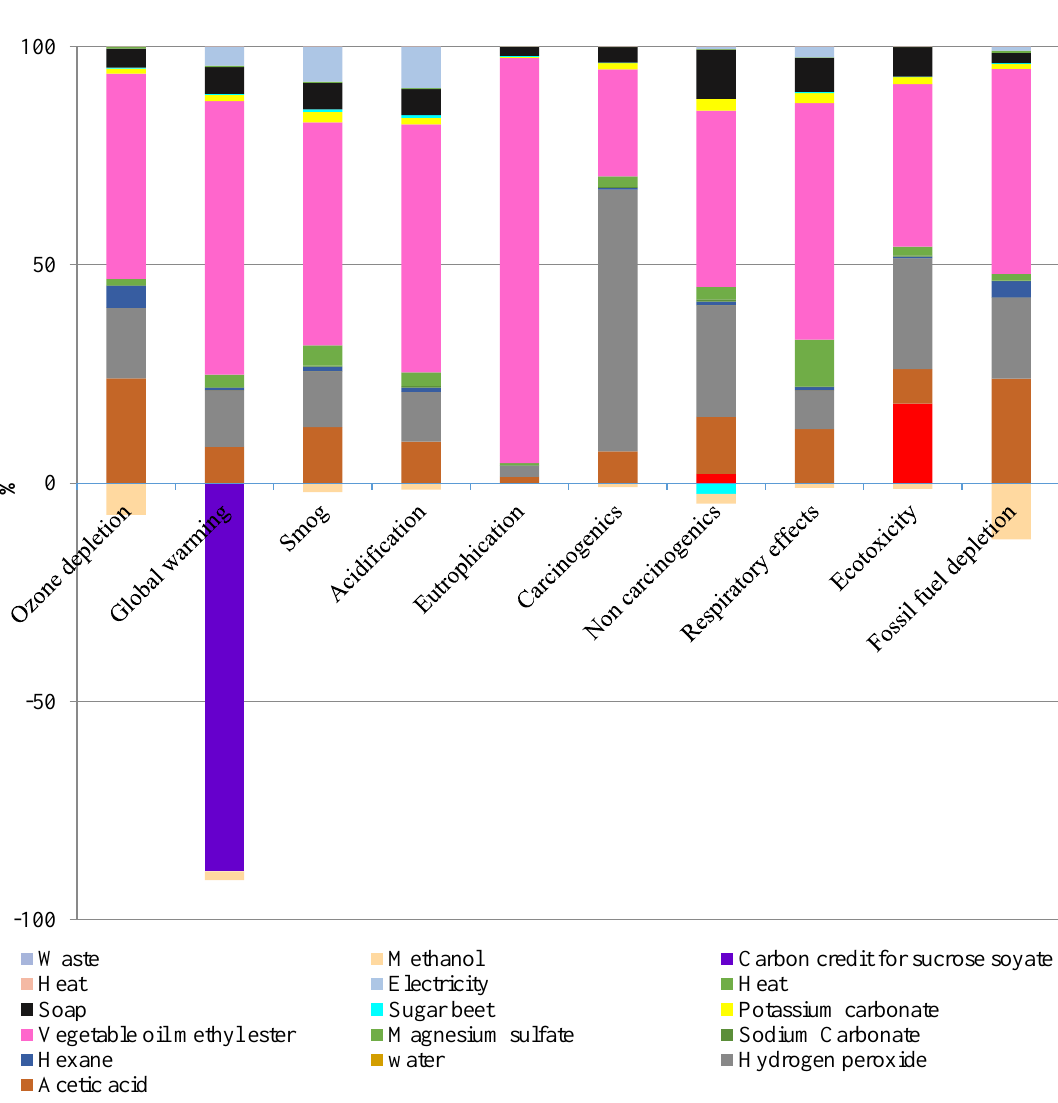
Figure 3. Life cycle environmental impacts of producing 1 kg of ESS using TRACI 2 method.